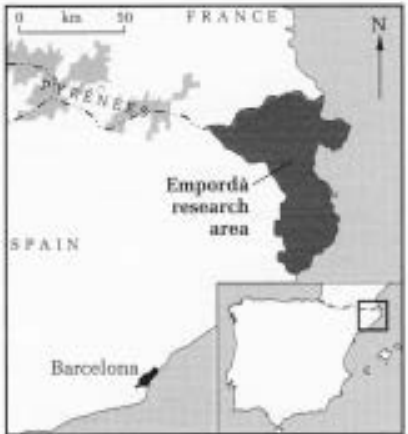
Figure 1 Location of the Emporda research